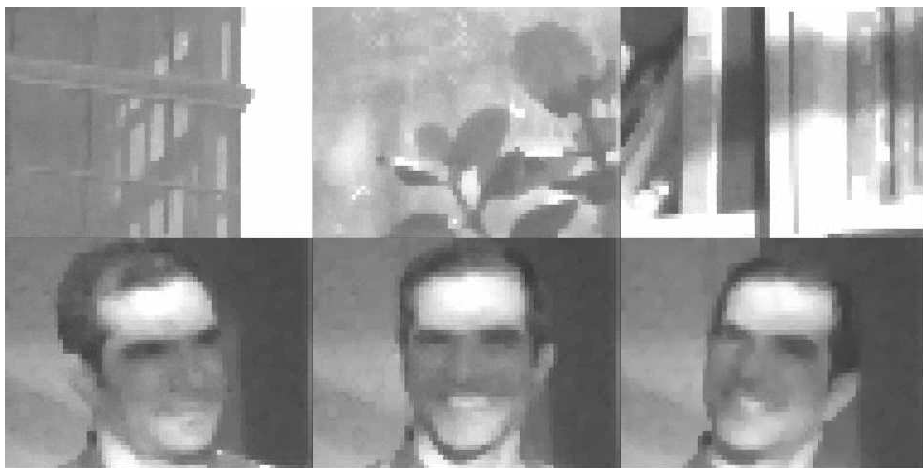
Figure 8. Polynomial-based correction in real time. Because the visual quality of quadratic FPN correction was deemed sufficient, with simple tone mapping, and the fixed-point work was unfinished at the time, the IPR( 2 ) method ( 3 ppp ) was implemented at a 30 Hz frame rate. Top row (left to right): a building against the sky; a plant by a window; and a bookshelf in sunlight. Bottom row: three views of a face with highlights and